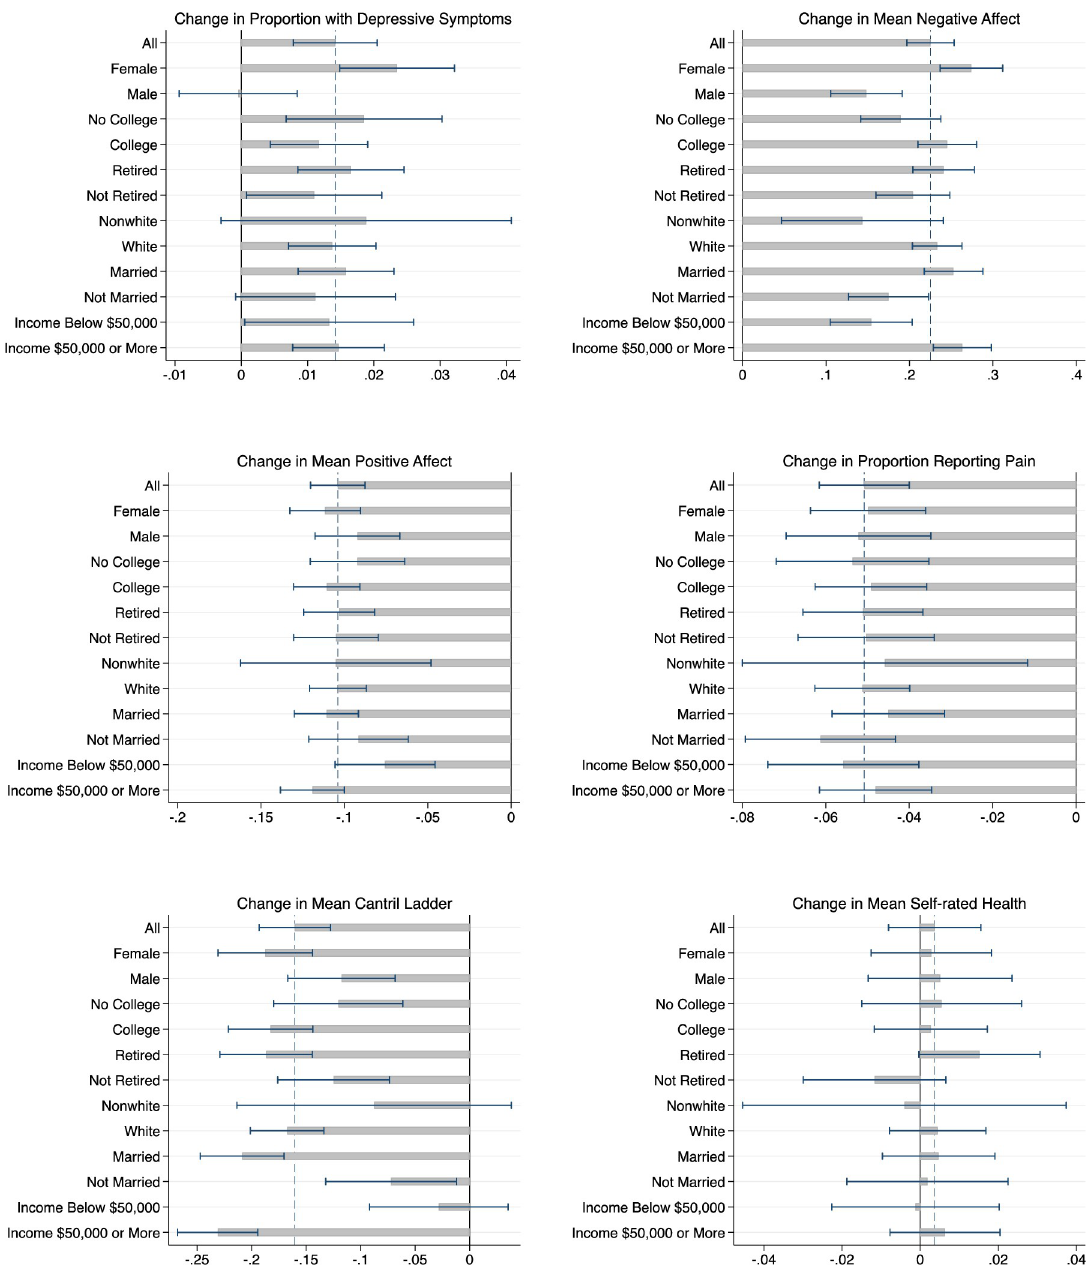
Fig 1. Changes in well-being by respondent characteristics. Notes: Each bar represents the wave 1 to wave 2 change, based on Eq (1), in the outcome for the specified sample–all respondents, females only, males only, those without a college degree, those with a college degree or higher, those who were retired at wave 1, those who were not retired at wave 1, those who are white, those who are non-white, those with household income below $50,000, those with household income at or above $50,000. The line at 0 denotes no change; the dashed blue line denotes the change for the overall